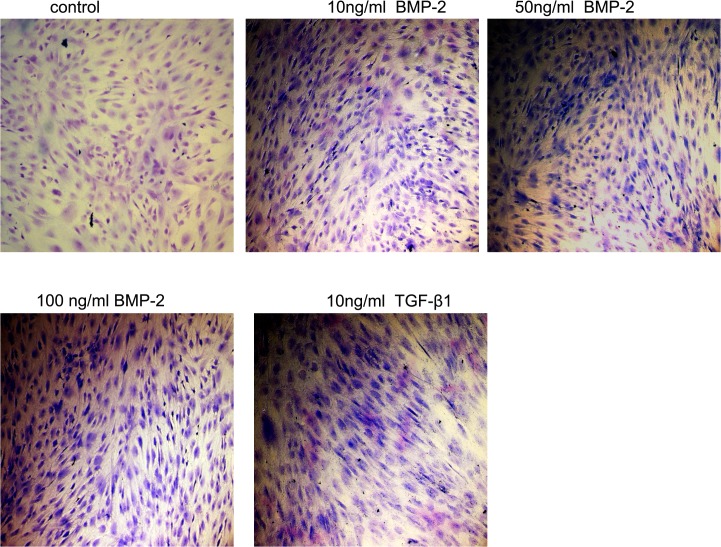
The effect of BMP-2 on GAG synthesis in HSFs.GAG synthesis was visualized by toluidine blue staining of HSFs in culture. GAG was observed after treatment with BMP-2 for one week but not in control cells. Original magnification: 40×.